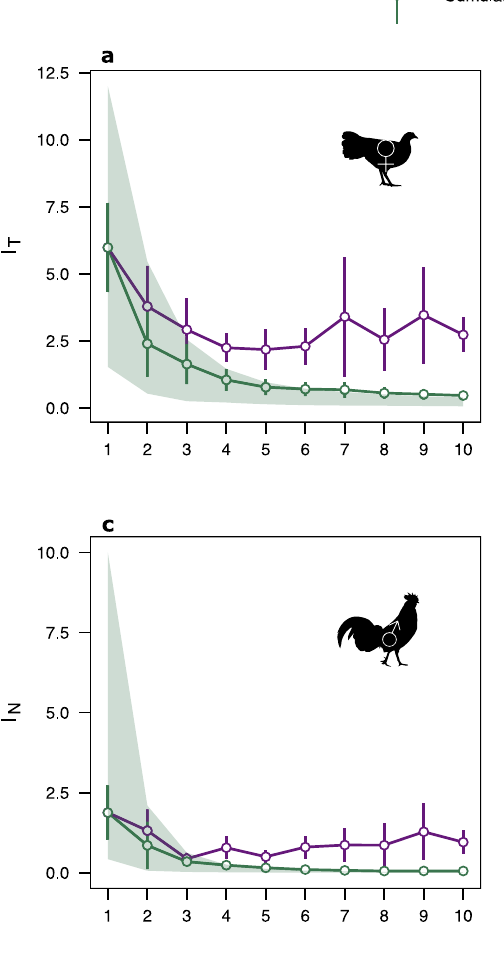
Fig. 2 | Short-term temporal dynamics in multiple opportunity for selection episodes in a polygynandrous bird. Patterns of opportunity estimates across different components of reproductive success in male and female red junglefowl ( Gallus gallus ) n groups=20. Points represent observed mean opportunity esti- mates, bars represent 95% con fi dence intervals (95% c.i.) and point colour re fl ects the sampling method (green: cumulative; purple: daily). Green shaded areas representexpectationsforcumulativemeasuresofopportunityforselectionbased on 10,000 random mating simulations (i.e. the 95% range of simulated